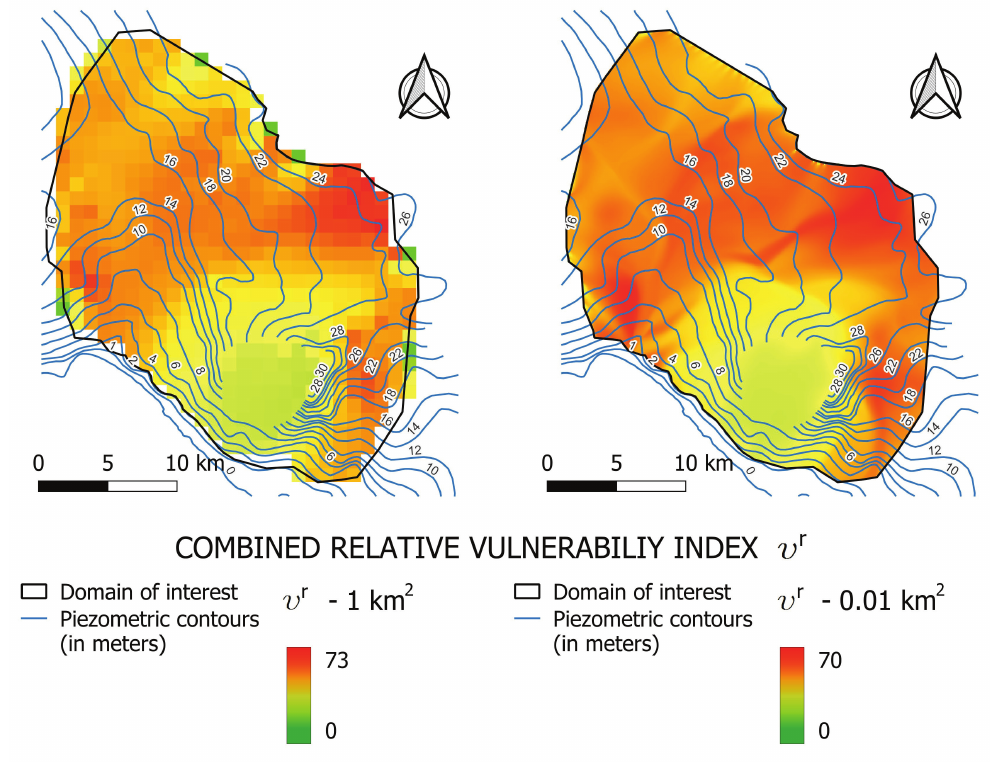
Figure 5. Combined relative vulnerability index υ r depicted in a log-scale for 2 different discretiza- tions (1 km 2 –0.1 km 2 ). The piezometric contours and the area analyzed are also shown. Combined relative vulnerability index υ r embeds information on the groundwater flow and the underlying trans- port mechanisms and represents the combined vulnerability index υ averaged over the groundwater